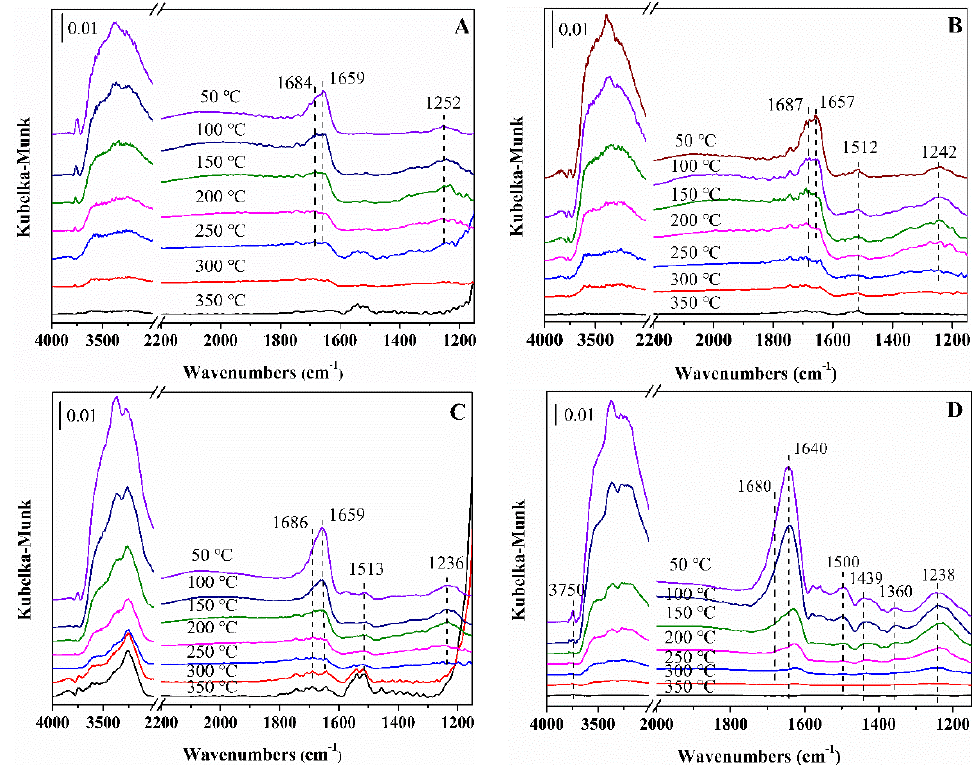
Figure 12. In situ DFIRTs of spectra of ( A ) MnAlO x -450 °C, ( B ) MnAlO x -550 °C, ( C ) MnAlO x -700 °C, ( D ) MnAlO x -800 °C catalysts under atmosphere of 500 ppm of NH 3 /N 2 (100 mL/min) at 50, 100, 150, 200, 250, 300, and 350 °C.